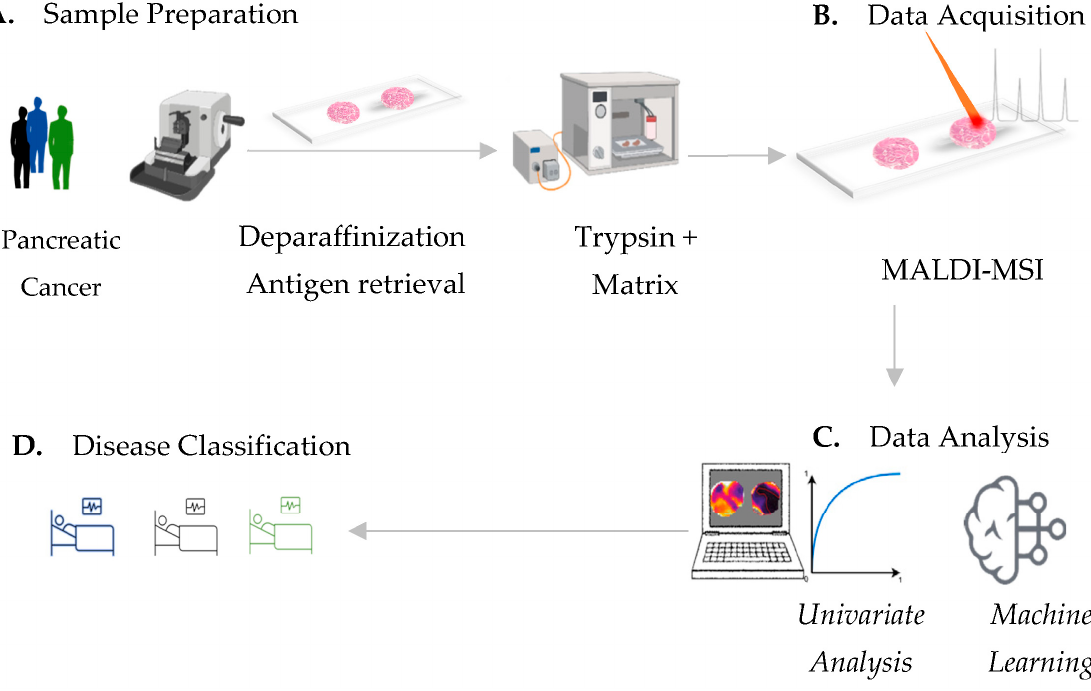
Table 1. Clinicopathological characteristics of our patient cohort. Study Group